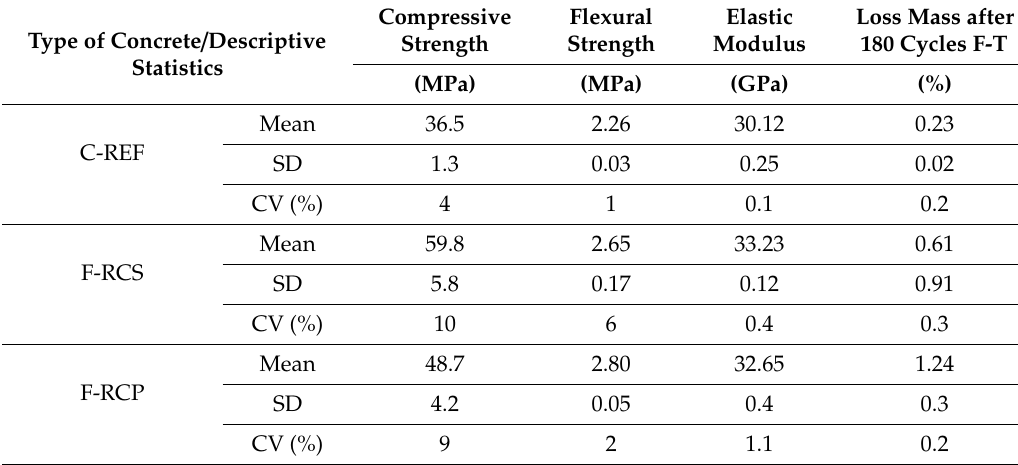
Table 9. Mechanical properties of the concretes.